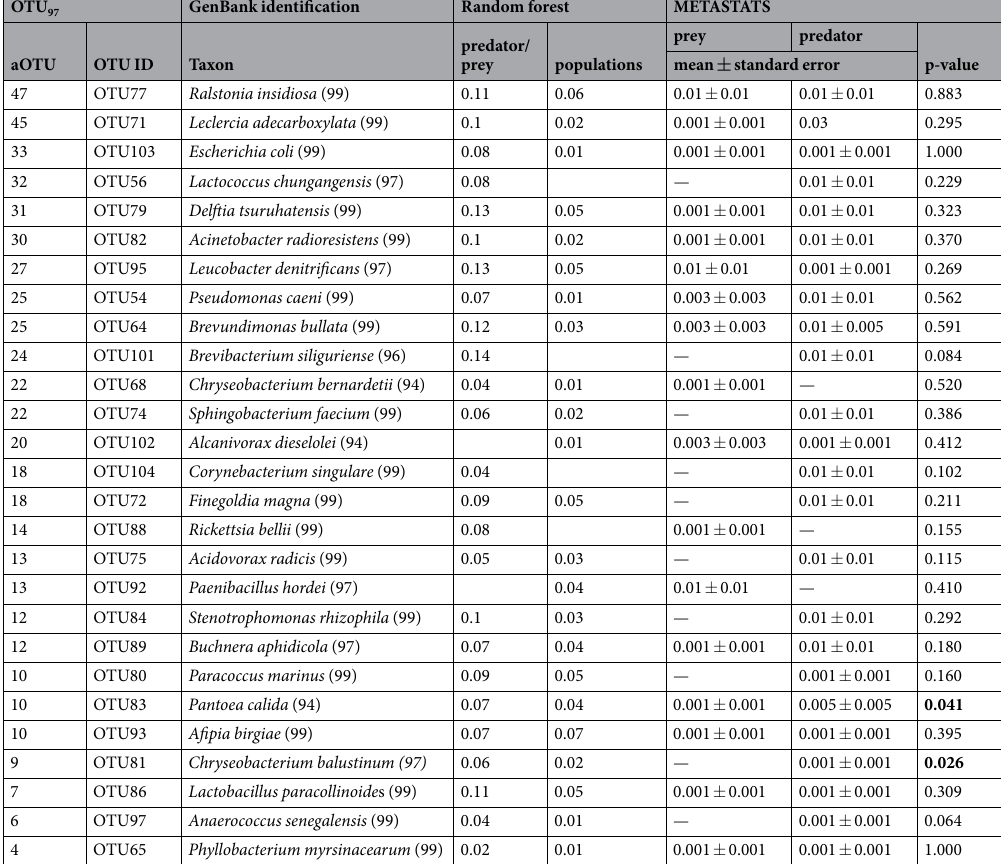
Table 1. The list of OTUs in the samples of predatory ( Neoseiulus cucumeris ) and prey ( Tyrophagus putrescentiae ) mites and the results of Random Forest and METASTATS analyses describing the means of relative abundance of OTUs (%) for the samples of predatory and prey mites. Supplementary Table S1 provides the extensive identification of OTUs. The random forest analyze was calculated for predatory/prey and populations as the factors (see Table S2), separately. The forest error rates were 0.33 and 0.53 respectively, aOTU - total number of sequnces in dataset, P-values < 0.05 are indicated by